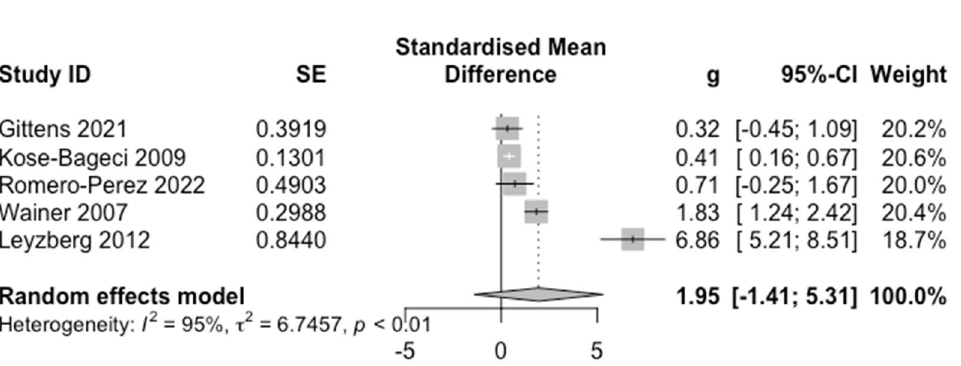
Figure 4. Forest Plot for PE. For each study and the average effect size, the plots show standardised mean differences (hedges’ g), standard error (SE), the 95% confidence interval (95% CI), and the weight in the random effect model. Heterogeneity is represented by the between study Higgins & Thompson’s 𝐼 (cid:2870) , heterogeneity variance 𝜏 (cid:2870) and p -value.